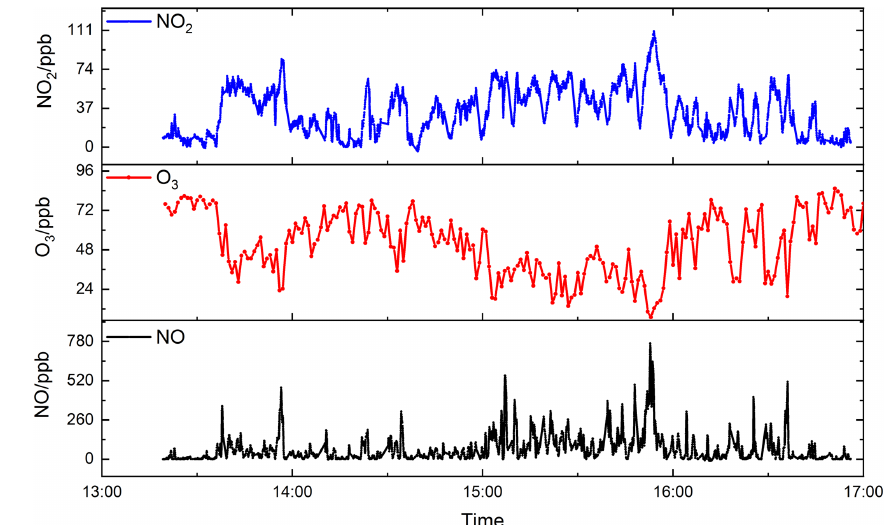
Figure 13. Results of the NO 2 , NO and O 3 concentrations around Hefei, China.